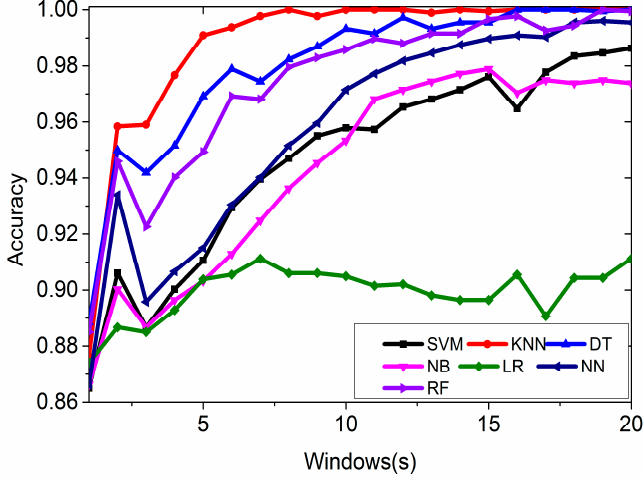
Figure 9. Classification accuracy using features varying with window length.